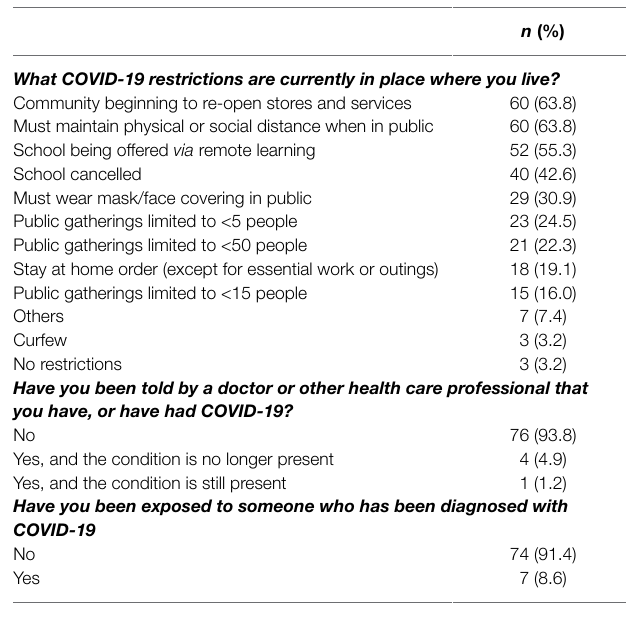
TABLE 2 | COVID-19 characteristics.